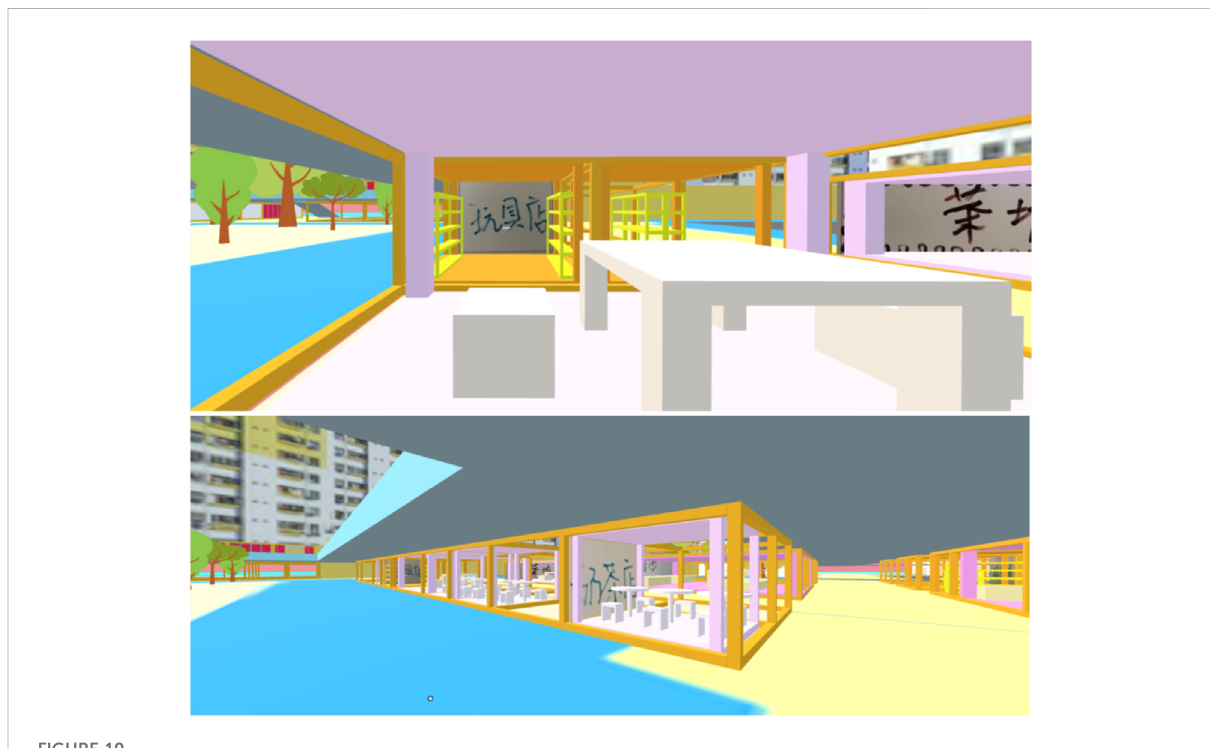
FIGURE 10 Design outcomes of the phase 2 game